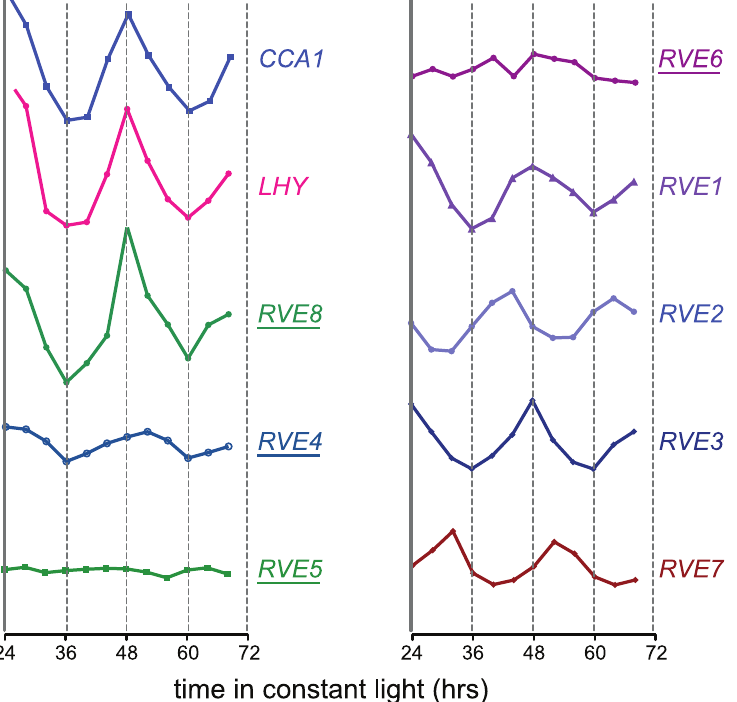
Figure 1. Circadian expression patterns of the CCA1 , LHY , and RVE genes. Expression of the RVE family of genes was assayed in a previously published microarray experiment [83]. Seedlings were entrained in LD 12:12 for 7 days before being transferred to constant white light. Plants were harvested at the indicated times and subjected to microarray analysis [83]. Relative expression levels of the different Myb-like genes are shown; all are graphed using the same scale. Underlined names indicate that peptides from the corresponding gene product were identified by mass spectrometry after affinity purification of EE-binding proteins. doi:10.1371/journal.pgen.1001350.g001 PLoS Genetics |